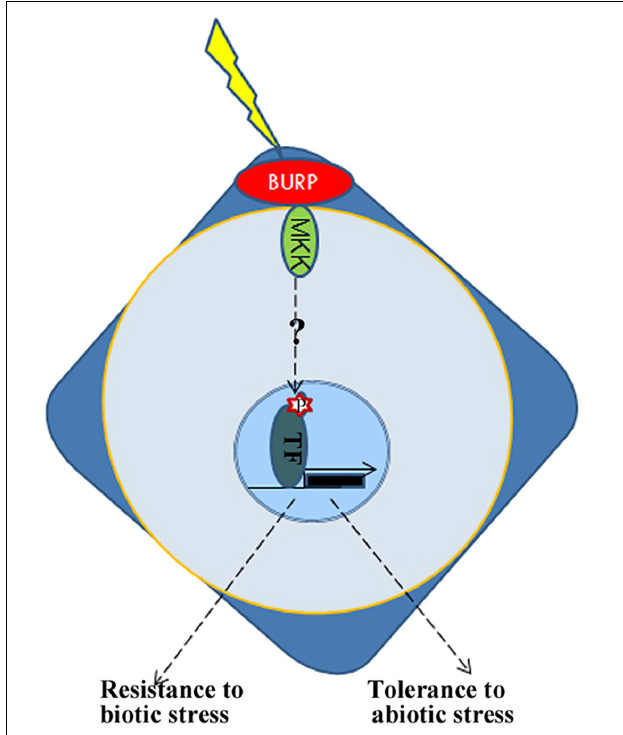
FIGURE 9 | Schematic representation of possible roles for BURPs in integrating abiotic and biotic stress responses. BURP, BURP-containing protein; MKK, Mitogen-activated protein kinase kinase; TF, transcription factor; P,